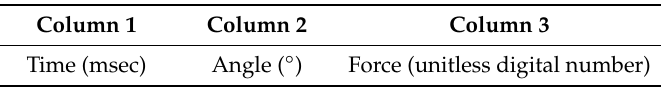
Table 2. Metadata for Stalker csv output.